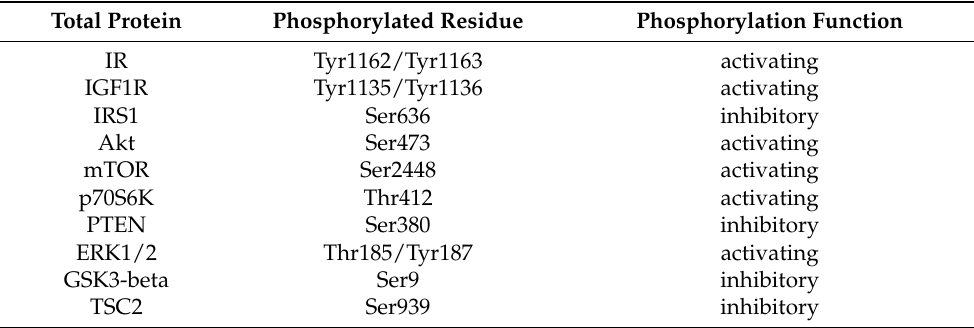
Table 4. Proteins involved in the insulin/IGF-1 signaling pathway, whose expression and phospho- rylation level were analyzed in esophageal biopsy specimens from Barrett’s lesion. Total Protein Phosphorylated